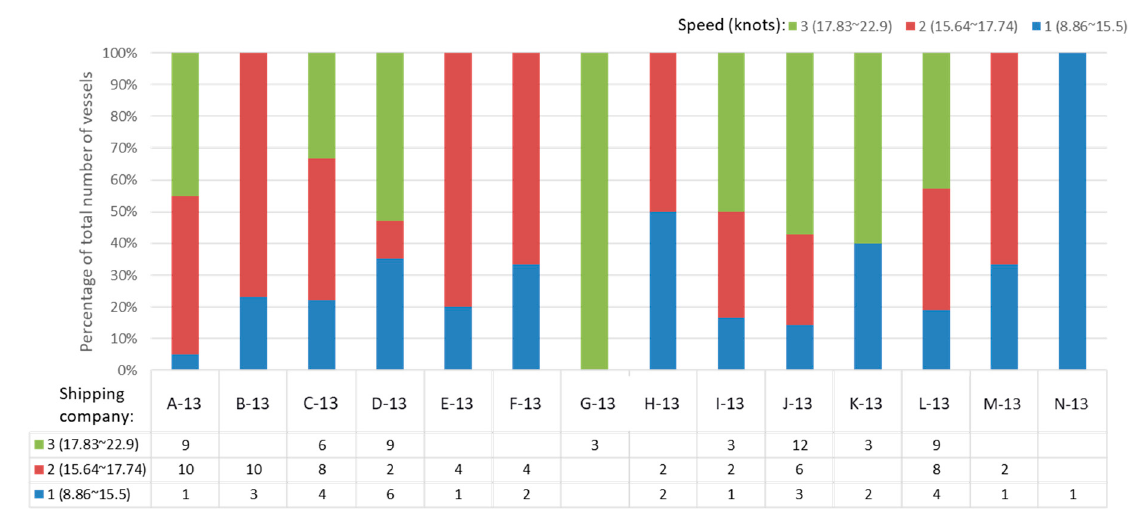
Figure 13. Speed clustering result of the 13,000 TEU container ships by shipping companies.